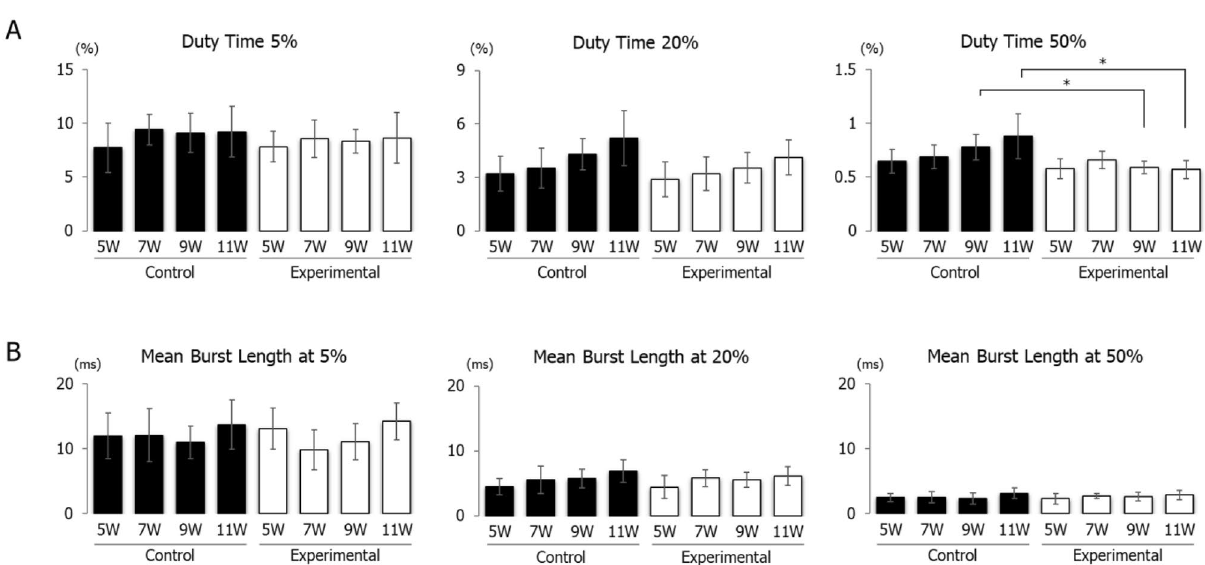
Figure 3. Longitudinal changes in duty time ( A ) and mean burst length ( B ) in the control and experimental groups. Values exceeding 5%, 20%, and 50% activity levels of the peak electromyographic activity are shown. Data are displayed as mean ± standard deviation. *p < 0.05 denotes significant differences between the control and experimental